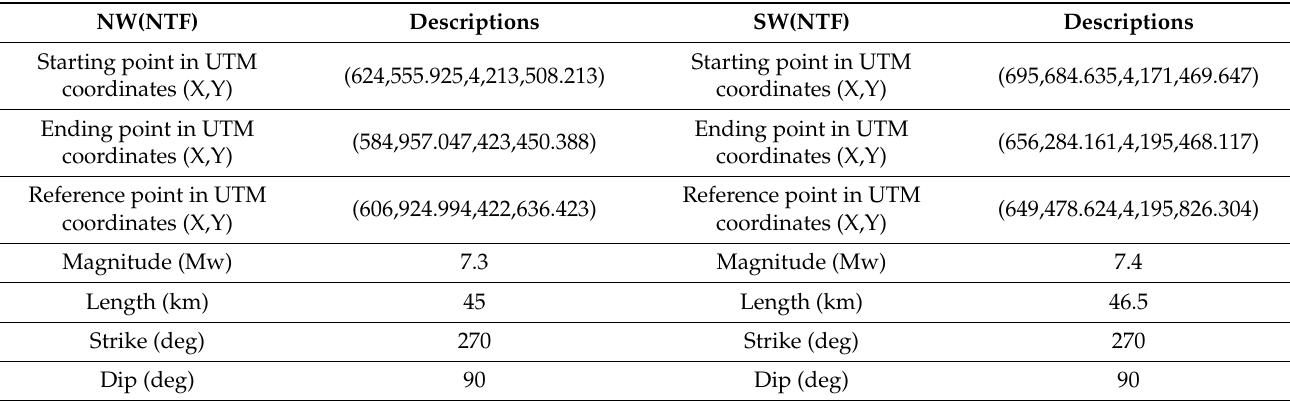
Table 3. Fault model elements of the source